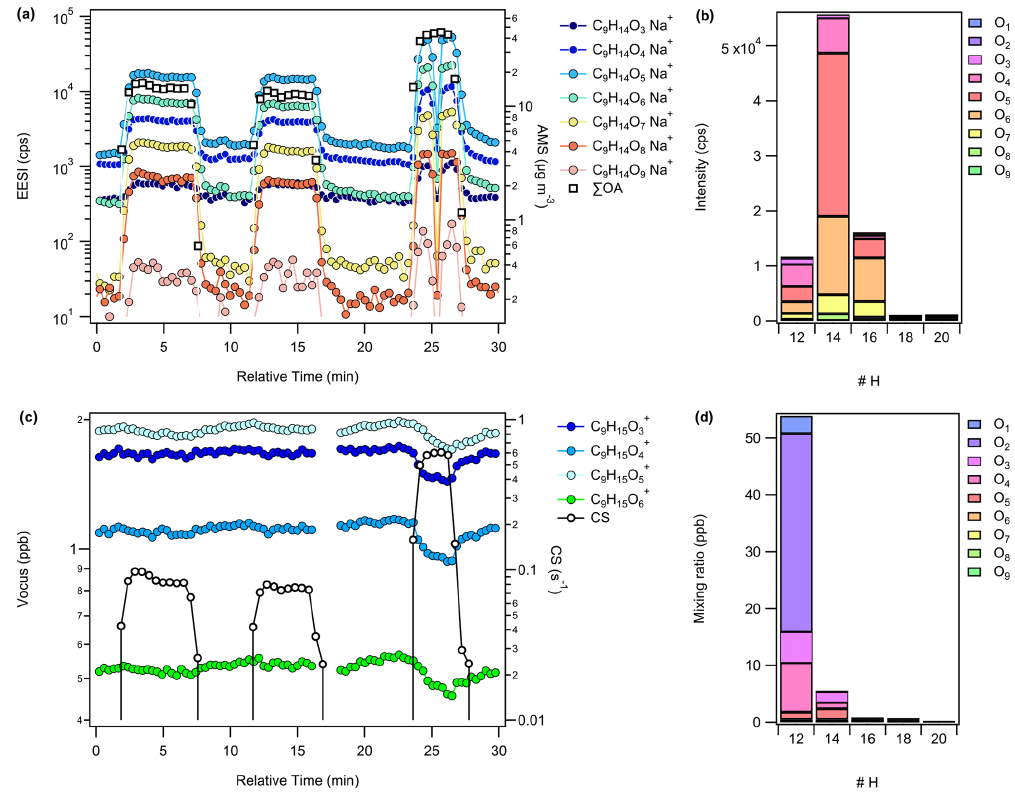
Figure 1. (a) Time series of particle-phase OH–TMB oxidation products, C 9 H 14 O x observed as Na + adduct ions by the EESI-TOF and the total organic aerosol concentration as observed by the AMS during three separate seed injection events. (b) Relative abundances of C 9 H 12 − 20 O 1–9 in the particle phase based on the ion intensities observed by the EESI-TOF averaged over all seed injection events. (c) Time series of select gas-phase C 9 H 14 O x products observed as protonated ions by the Vocus-PTR and the estimated condensation sink. (d) Relative abundances of C 9 H 12–20 O 1–9 in the gas phase based on the mixing ratios estimated by the Vocus-PTR averaged over all steady-state periods prior to the seed injection events. The decrease in EESI-TOF intensity in (a) at 25min corresponds to an automated background filter measurement. The gap in the Vocus-PTR time series in (c) at around 16min corresponds to an automated background zero air